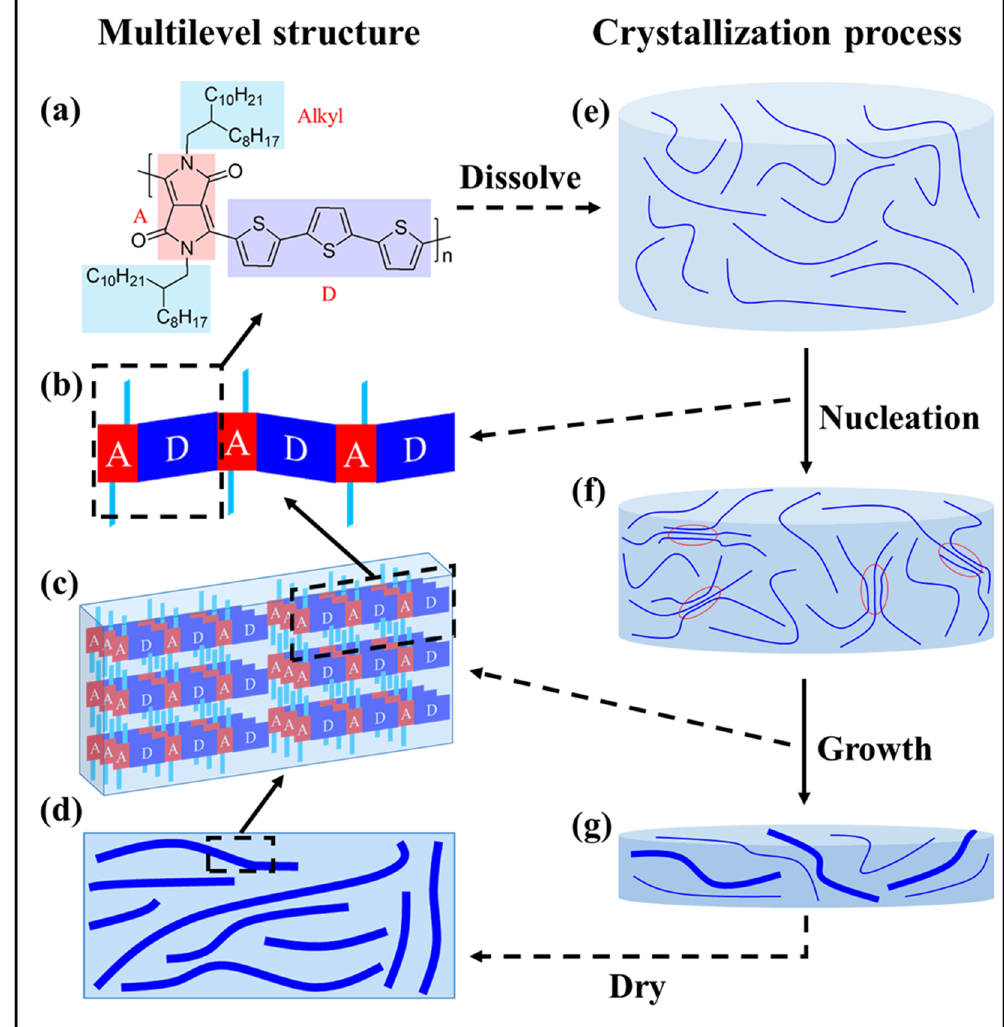
Figure 1. Schematic diagrams of the multilevel structure in D-A conjugated polymer films ( left ) and the typical crystallization process of D-A conjugated polymers ( right ). ( a ) represents the chemical structure of D-A conjugated polymers; ( b ) represents the chain conformation of D-A conjugated polymers; ( c ) represents the crystal structure of D-A conjugated polymers; ( d ) represents the film structure of D-A conjugated polymers; ( e ) represents D-A conjugated polymer solution; ( f ) represents the nucleation of D-A conjugated polymer crystals; and ( g ) represents the growth of D-A conjugated polymer crystals.